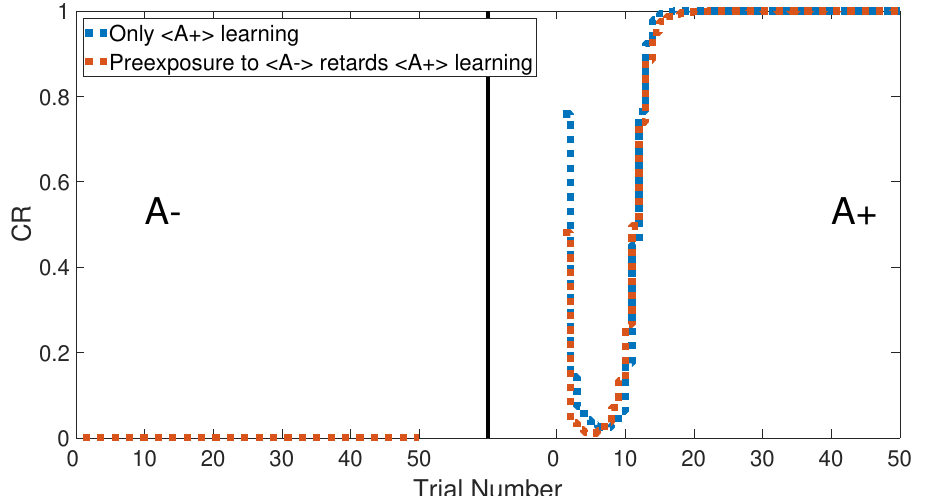
Figure 23. Latent inhibition task for the lesioned system of CHCQ model with and without a